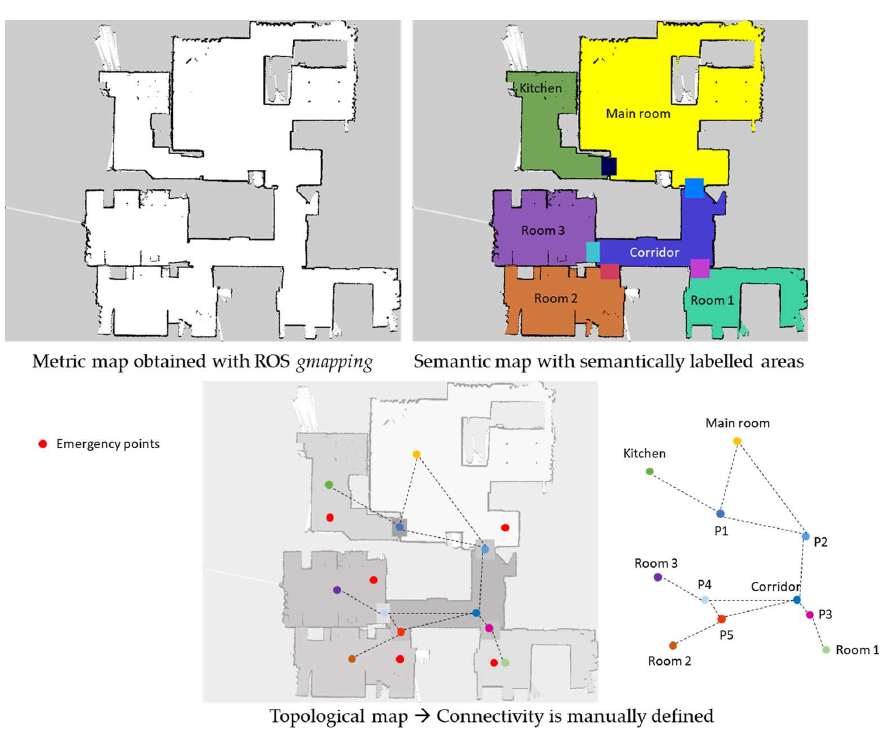
Figure 5. Collection of superposed maps: Metric, semantic and topological with the details of relevant points that represent areas and emergency places. Points with different colors defines representative locations in each specific area of the semantic map. Red points are considered as emergency points and they do not define nodes included in the graph that represents the topological map. Representative points of areas that connect different semantic regions are identified as Pi, where “i” is defined as a number.